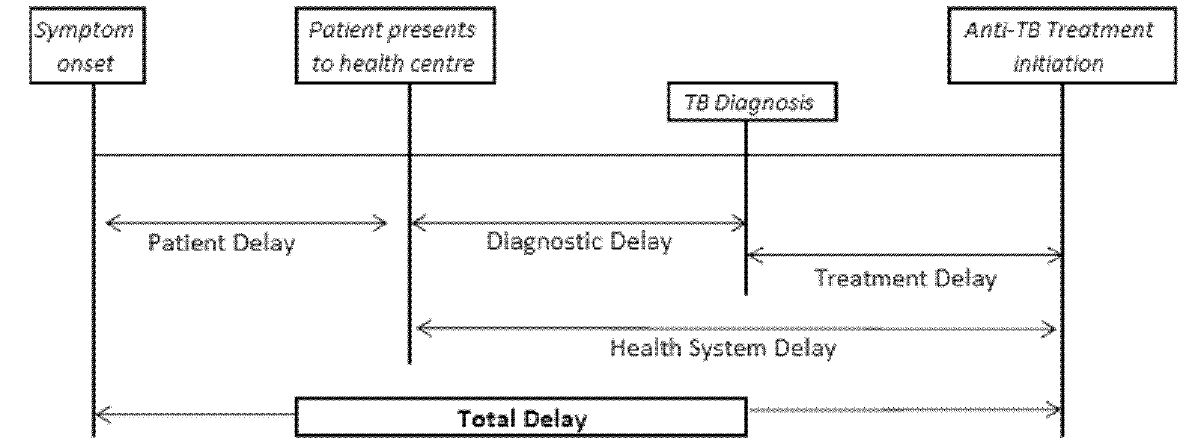
Figure 1. Different categories of delay and their contribution to total delay.